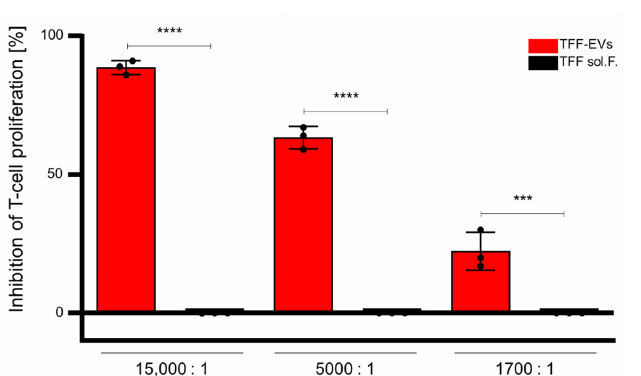
Figure A1. HPL-derived TFF-EVs but not soluble factors inhibit T cell proliferation. Peripheral blood mononuclear cells, containing approximately 80% of T cells, were incubated with TFF-EVs or TFF soluble fraction (sol.F.; volume-normalized according to TFF EVs) for 4 days, concomitantly with phytohemagglutinin (PHA). Inhibition of PHA-induced T-cell proliferation was then accessed, showing TFF-EVs to have the strongest inhibitory potential on all tested concentrations. One-way ANOVA/Tukey **** p ≤ 0.0001 and *** p ≤ 0.001. One biological replicate performed in triplicates.